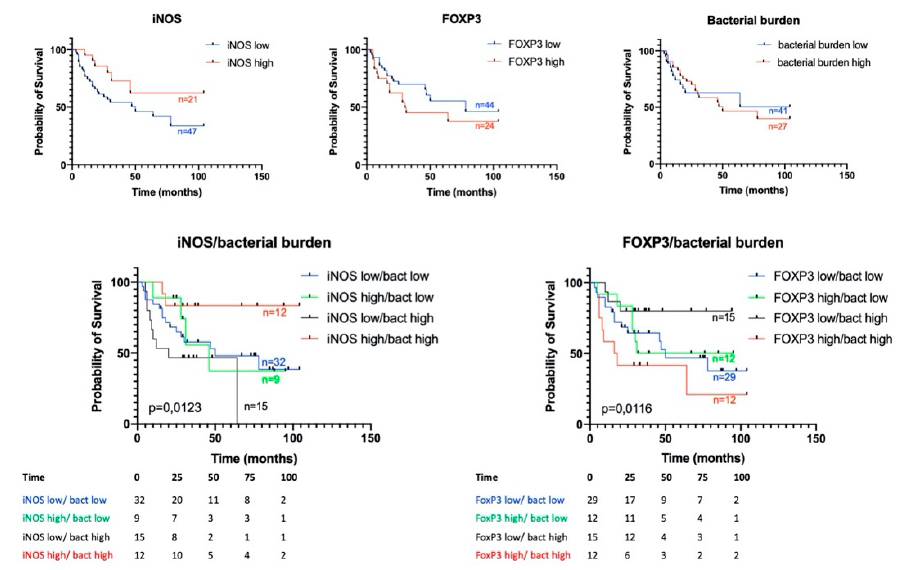
Figure 7. Kaplan–Meier curves of overall survival (OS) in NSCLC based on iNOS and FOXP3 expression and bacterial burden. For the curves the iNOS / bacterial burden and FoxP3 / bacterial burden number at risk for 25, 50, 75 and 100 months are provided below the graphs.